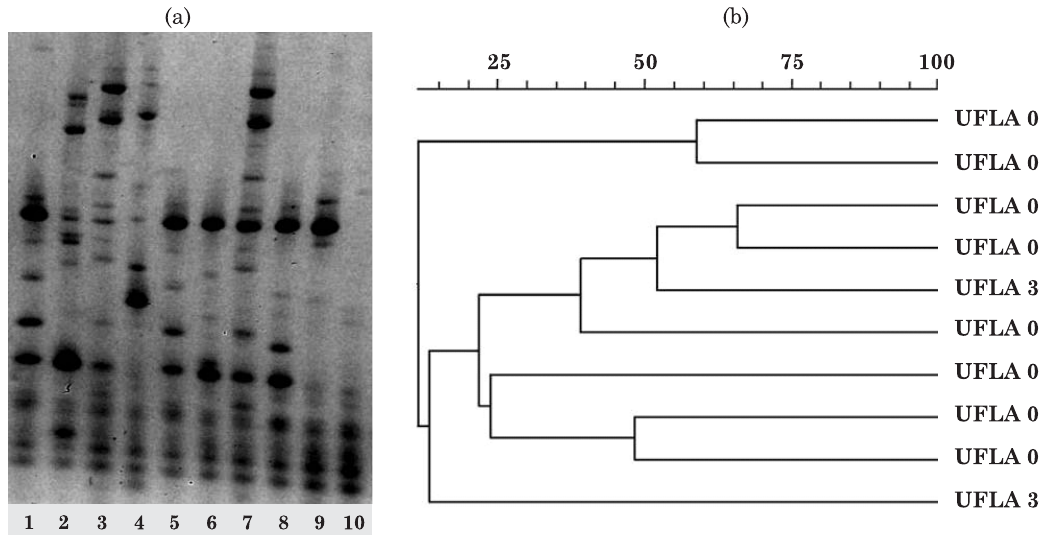
Figure 1. (a) PCR fragments obtained by amplification with the BOX primer using DNA from cowpea- isolated Bradyrhizobium strains (2: UFLA 03–28; 3: UFLA 03–33; 4: UFLA 03–34; 5: UFLA 03–31; 6: UFLA 03–29; 7: UFLA 03–38; 8: UFLA 03–30; 9: UFLA 03–37) and from strains of the genus